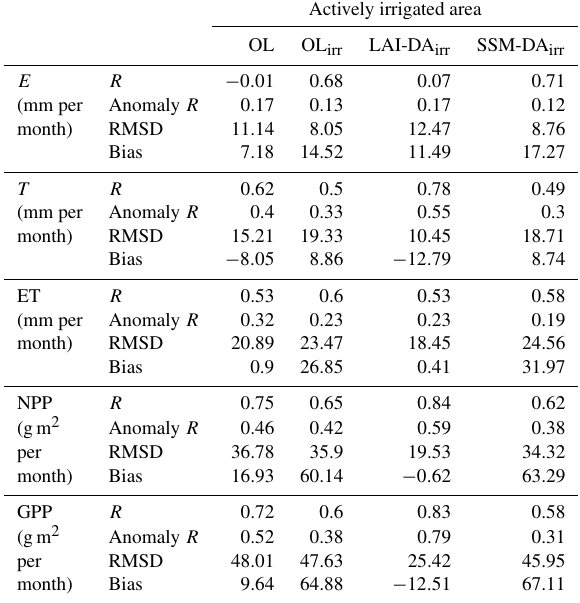
Table 4. Median evaluation metrics of monthly correlation ( R ), anomaly correlation (anomaly R ), RMSD, and bias for the OL, OL irr , LAI-DA irr and SSM-DA irr simulations against FAO WaPOR data sets for evaporation ( E ), transpiration ( T ), evapotranspira- tion (ET), net primary production (NPP), and against the FLUXSAT data set for gross primary production (GPP) for the period of 2015– 2019 over the actively irrigated